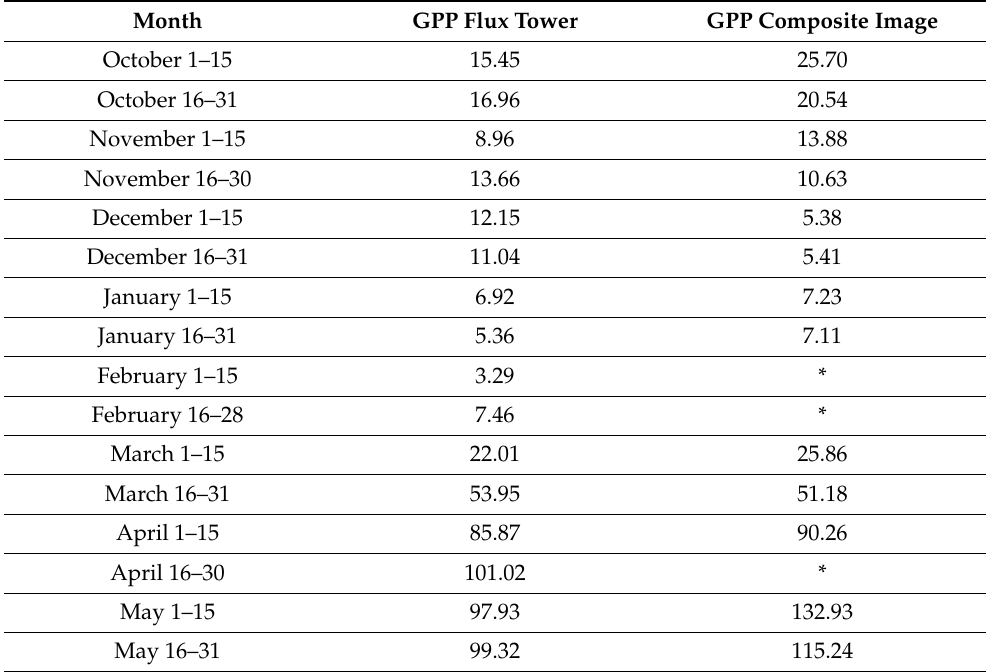
Table 9. Monthly carbon fluxes retrieved from the Duque Fuente flux tower and predicted for the climatological footprint using a single 15-day composite image.